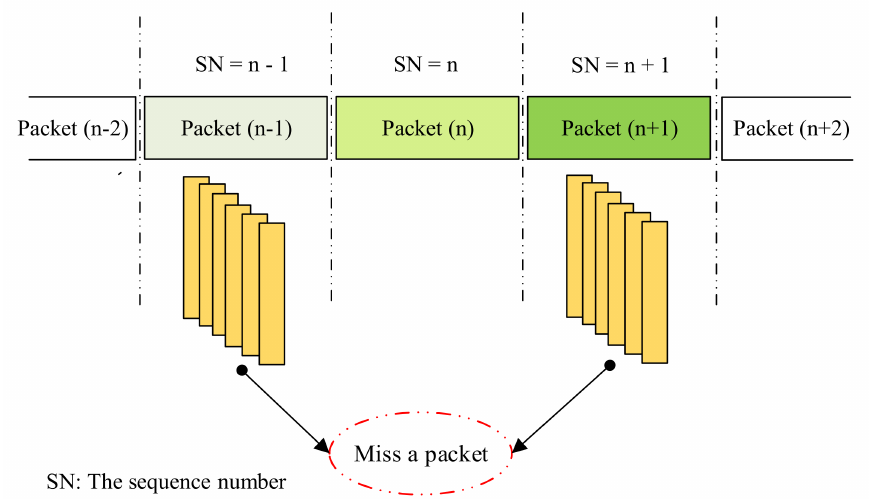
Figure 14. Error detection in grouping image during undersampling